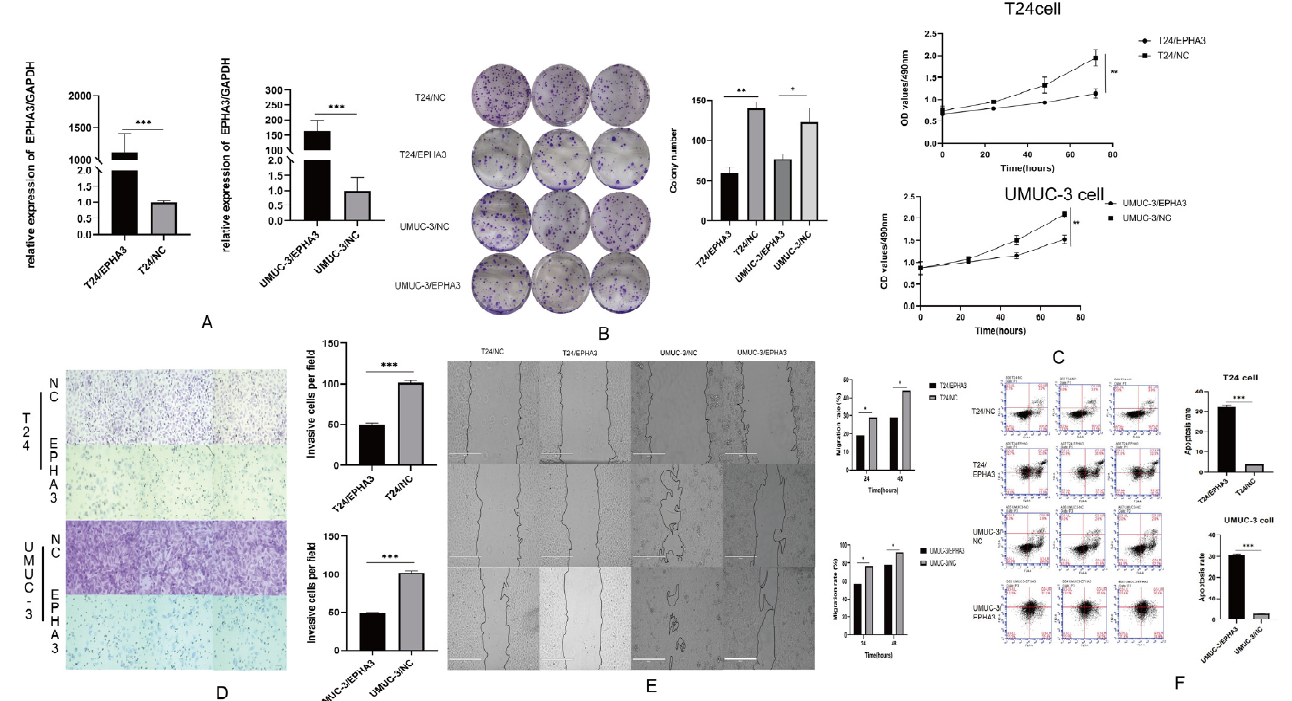
Figure 10. Functional assays of overexpressed EPHA3 and negative control (NC) cells in each group. ( A ) The EPHA3 mRNA levels within T24/NC, T24/EPHA3, UMUC-3/NC, and UMUC-3/EPHA3 groups. ( B – C ) The cell proliferation assays were performed by colony formation and CCK8 assay. ( D – E ) Changes in cell invasion and migration abilities after overexpressing EPHA3 in T24 and UMUC-3 cells were measured through Transwell and wound-healing assays. ( F ) An enhancement of the number of apoptotic cells was found after overexpressing EPHA3 in T24 and UMUC-3 cells. The total assays were calculated by the software ImageJ (Version 1.48) and the results were visualized by GraphPad Prism software (GraphPad 6.0, Dotmatics, Boston, MA, USA). * p < 0.05, ** p < 0.01, and *** p < 0.001.